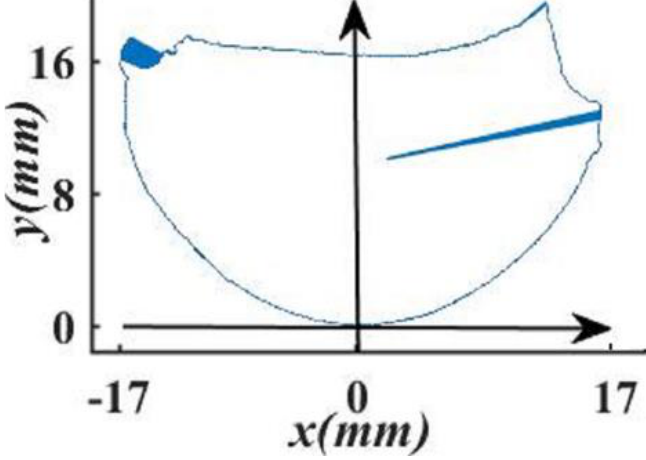
Figure 7. Extraction of garlic contour.